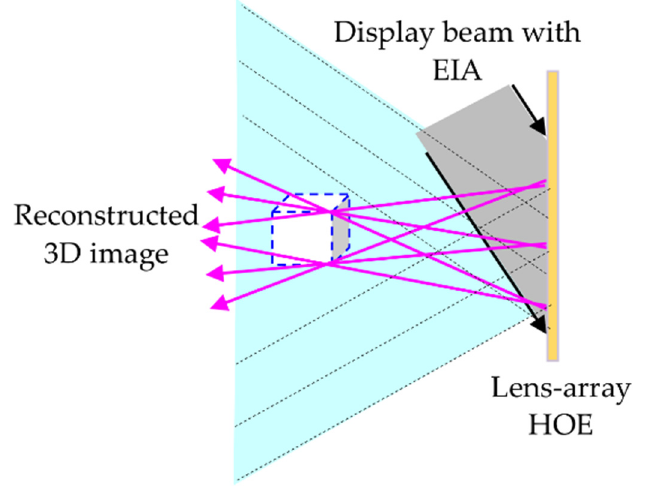
Figure 3. Reconstruction principle of a 3D image using the lens-array HOE.